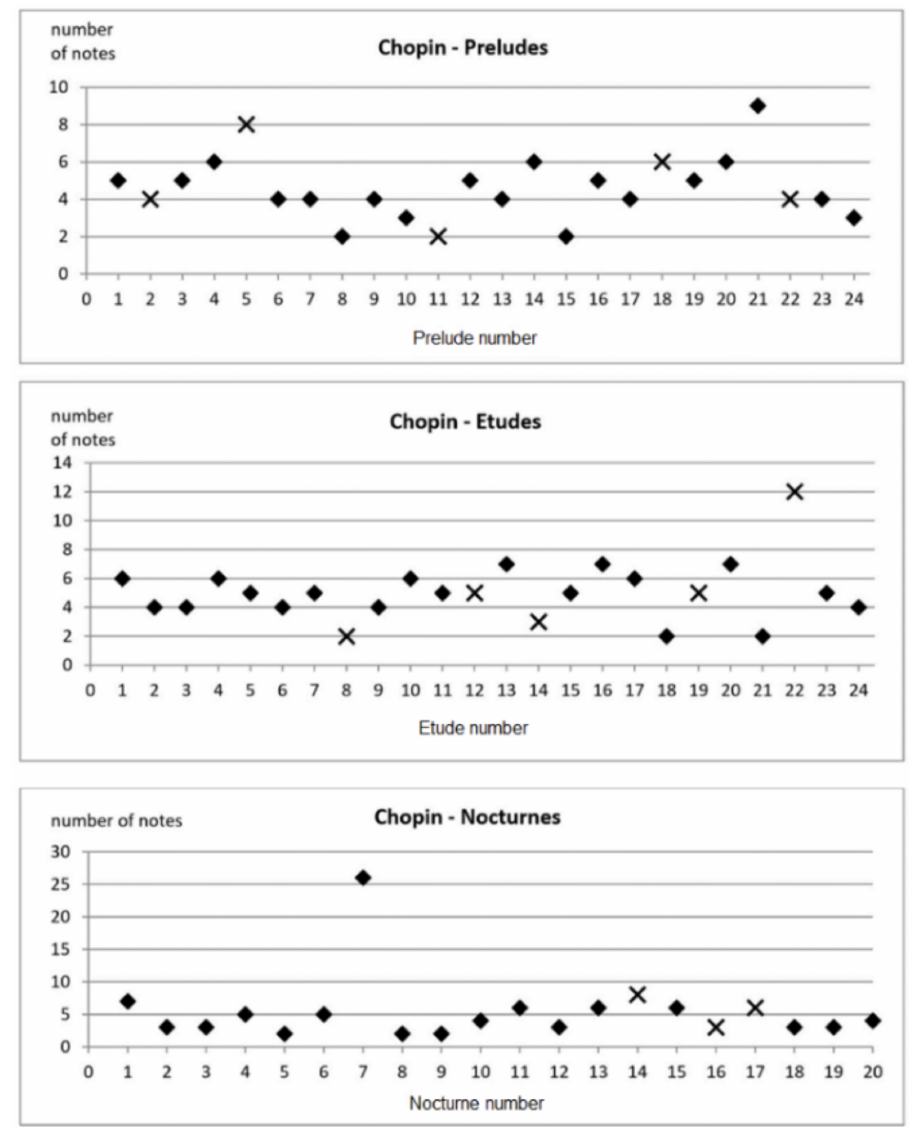
Figure 7. The number of notes needed to determine the key signatures of the analyzed fragments of music by F. Chopin: (cid:7) —correct recognition of the key signature; x—incorrect recognition of the key